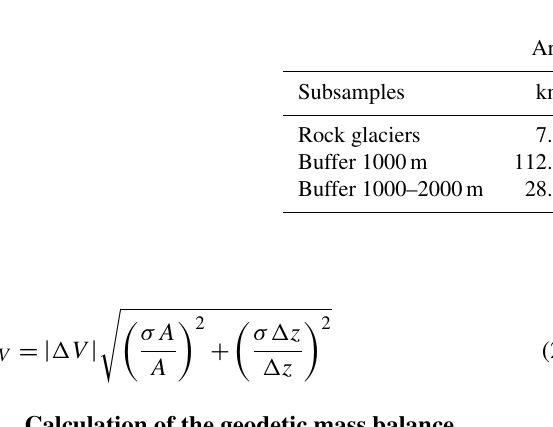
Table 1. Instrument, minimum point density, and pixel size of the lidar campaigns used in this study for the calculation of volume changes. Federal region Year of Lidar Minimum point DEM cell survey instrument density/m 2 points per m Tyrol 2006 ALTM 3100 and Gemini 0.25 1.0 Tyrol 2018 Riegl VQ 780 8.00 1.0 Vorarlberg 2004 ALTM 2050 2.50 1.0 Vorarlberg 0.5 Table 2. Comparison of the slope and elevation change (mean, standard deviation) between 2004/2006 and 2017/2018 for three subsamples. Elevation change Slope ( (cid:49)z ) Area Mean σ Mean σ Subsamples km 2 Rock